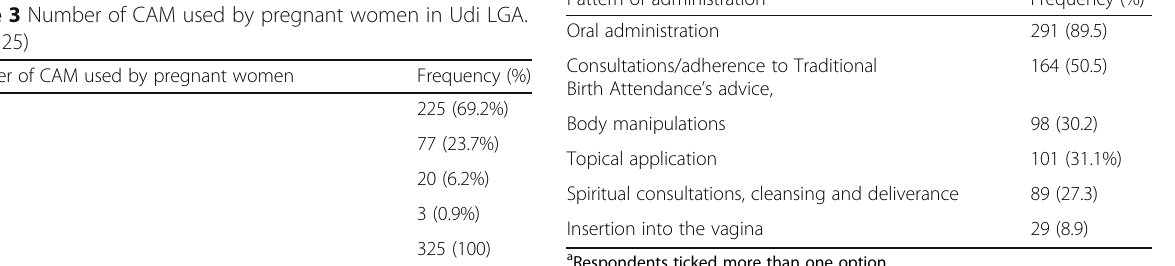
Table 3 Number of CAM used by pregnant women in Udi LGA.